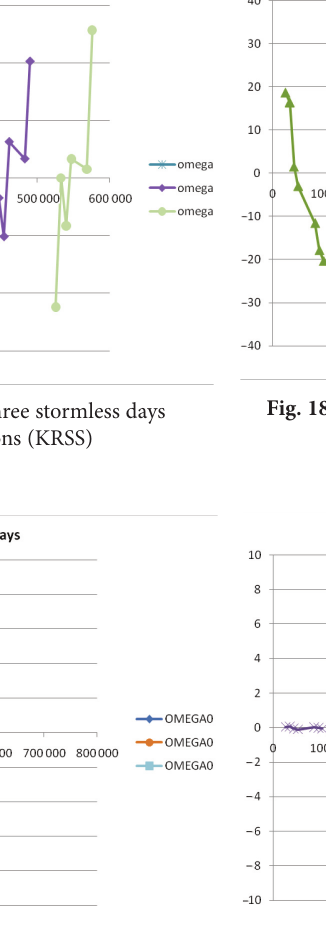
Fig.19. The eccentricity of three stormless days in 2010 using cPOS stations